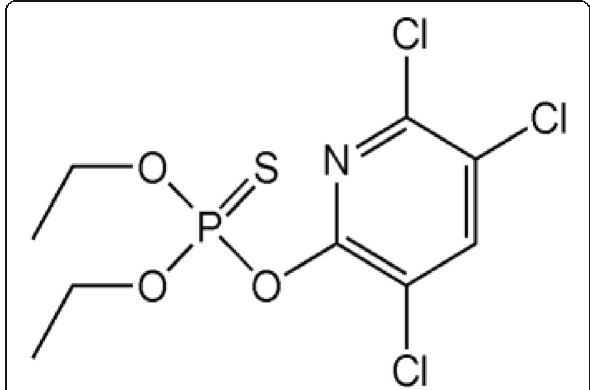
Fig. 1 O, O ′ - diethyl ester-O ″ -(3, 5, 6-trichloro-pyridin-2-yl phosphorothioate)